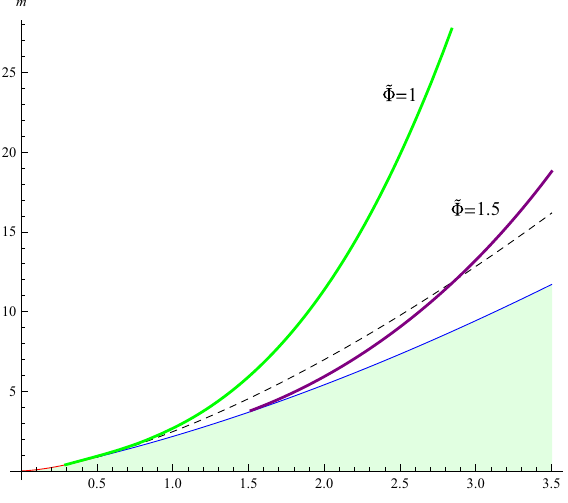
Fig. 3 Curves of constant potential ˜ (cid:3) = 1 and 1 . 5 in the case with d = 3, k = 1, L = 1 and β = 1